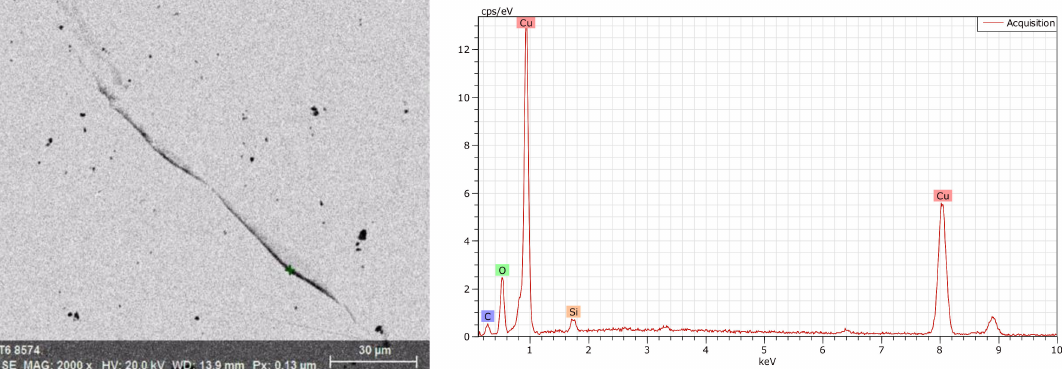
Figure 4. Energy spectrum analysis at the crack.